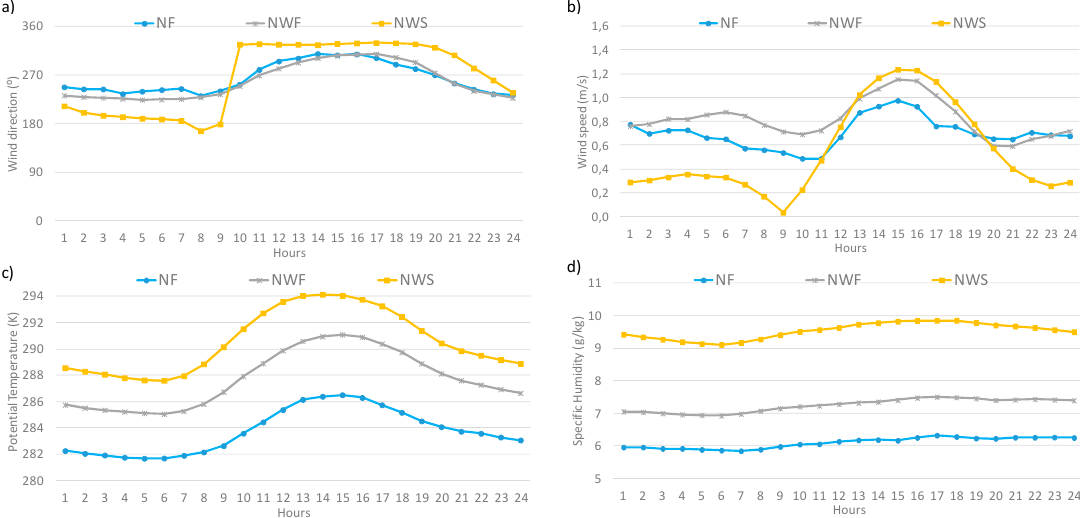
Figure 12. Daily cycles of ( a ) wind direction and ( b ) speed, ( c ) potential temperature, and ( d ) specific humidity associated with di ff erent airflow patterns at Bilbao. Only persistent sampling periods are used.